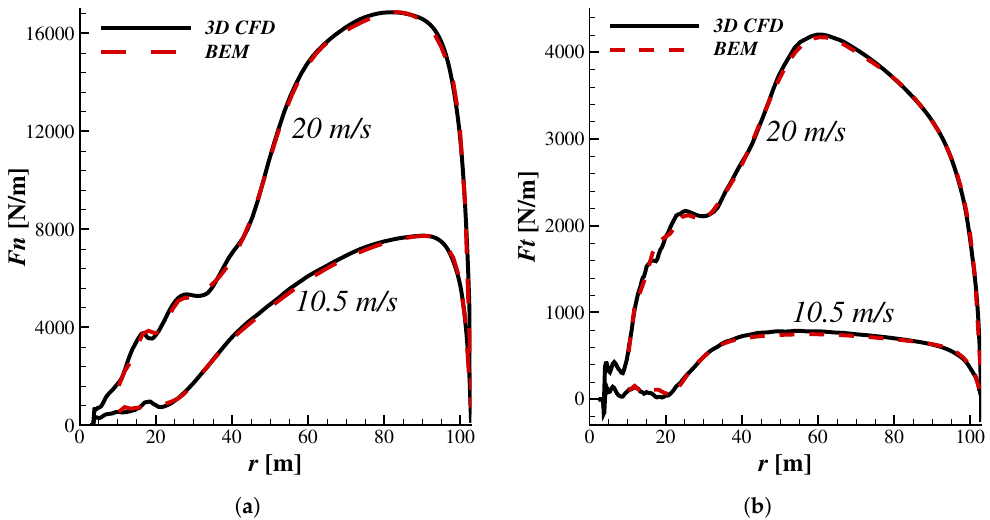
Figure 17. Sectional loads predicted by BEM and CFD for two different wind speeds. 3D polar and cubic-spline interpolation are employed; ( a ) normal force, ( b ) tangential force.